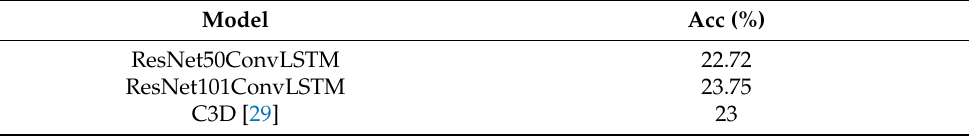
Table 7. Accuracy for 14 categories classification on the UCF-Crime dataset.